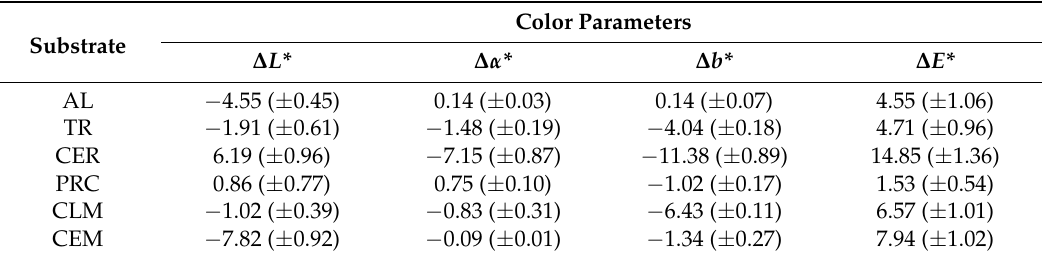
Table 3. Color changes of L *, α * and b * parameters before and after treatment with TCO&SP&T layers.